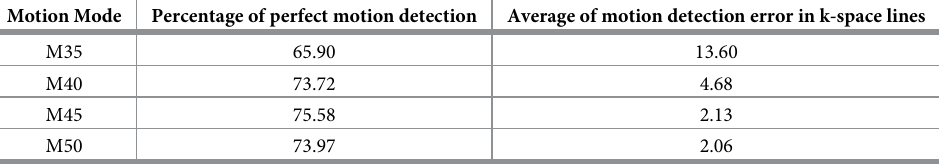
Table 1. Results of motion